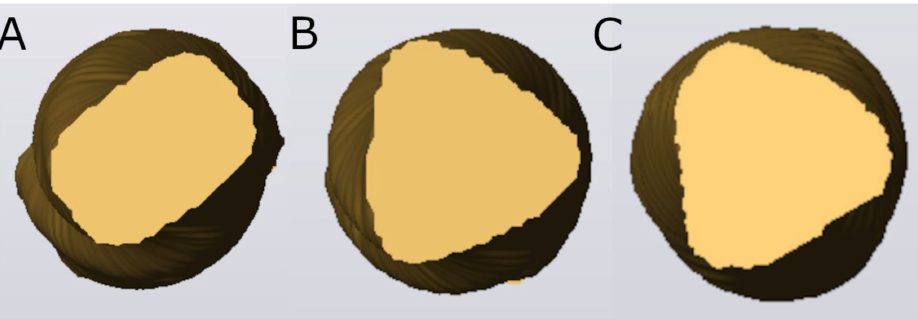
Figure 6. STL digital files of the cross-section geometries of: ( A ) EDG NiTi alloy endodontic rotary file, ( B ) PMP heat-treated NiTi alloy endodontic rotary file, and ( C ) ST heat-treated NiTi alloy endodontic reciprocating file.